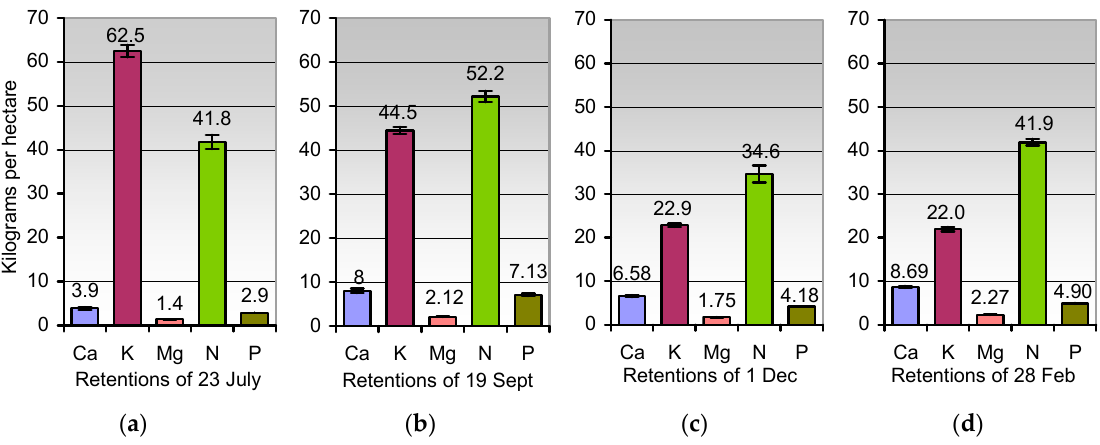
Figure 4. Rotation wheat-maize: The cropland retention of the minerals (kg ha − 1 , figures heading the columns) in rooted stubbles 16 cm, in grains lost during harvest, and in the regrowth of wheat from spilt grains at 23 July ( a ), 19 September ( b ), 1 December ( c ), and 28 February ( d ). See Table 3 for details. Error bars indicate ± SD. NPK stock in stubbles/roots from 23 July to 28 February (kg ha − 1 ): 107.2, 103.8, 61.7, 68.8.